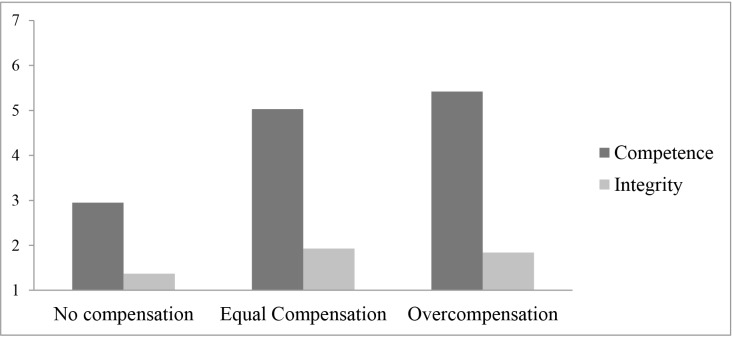
Trusting intentions as a function of violation type and compensation size.